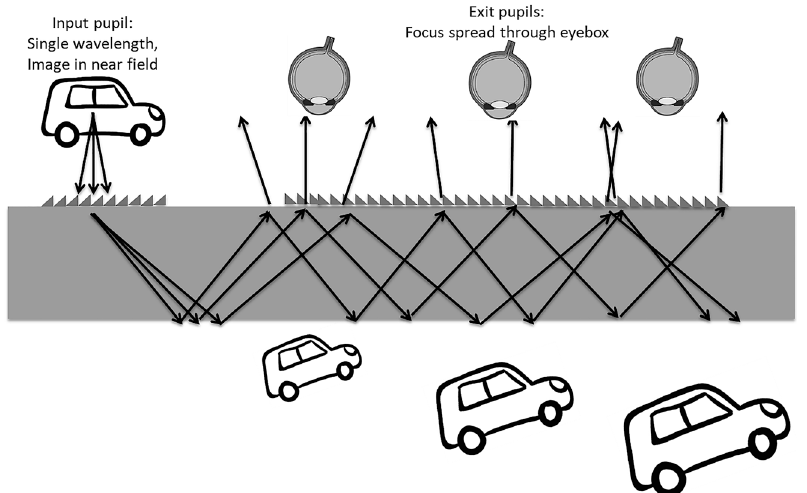
Figure 25: Focus spread in a waveguide combiner with a noncollimated input field.